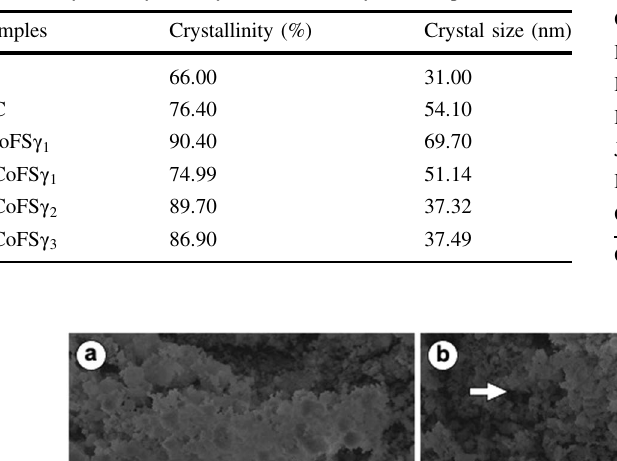
Table 2 Crystallinity and crystallite size of hybrid composites